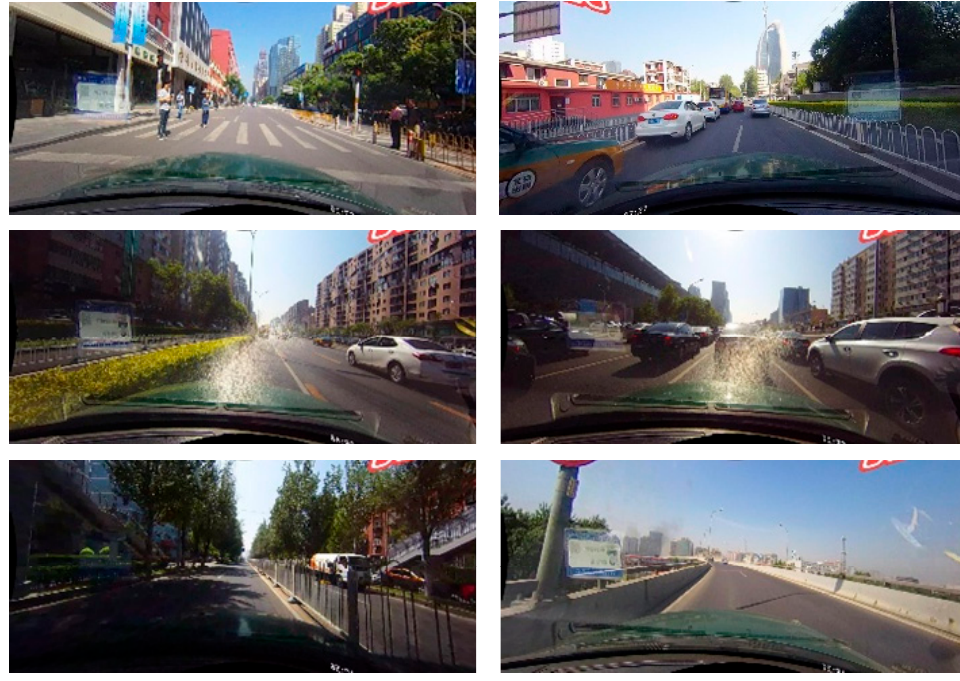
Figure 4. CuLane dataset example in different scenarios.